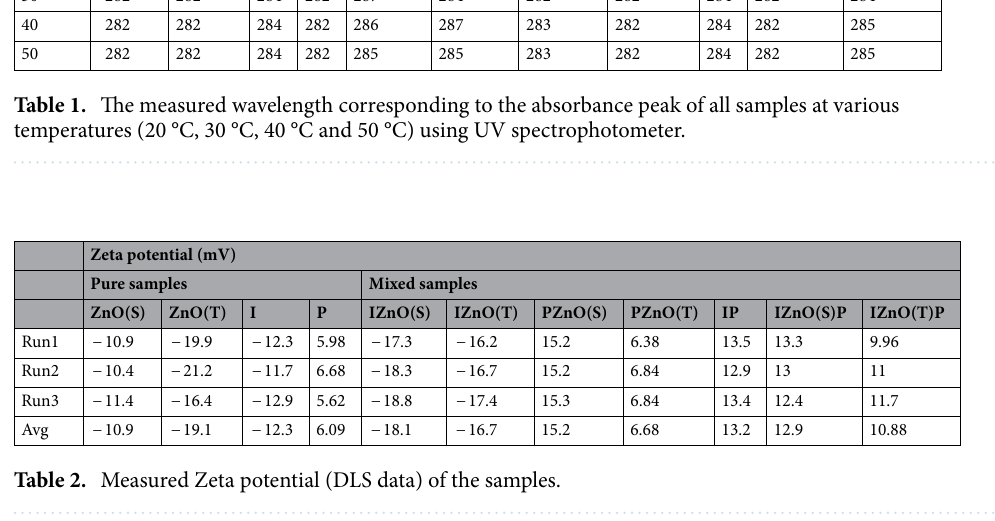
Table 3). Maximum enthalpy change is found for Insulin + papain which validate the volatile behavior of papain as observed in dielectric studies. Discussion